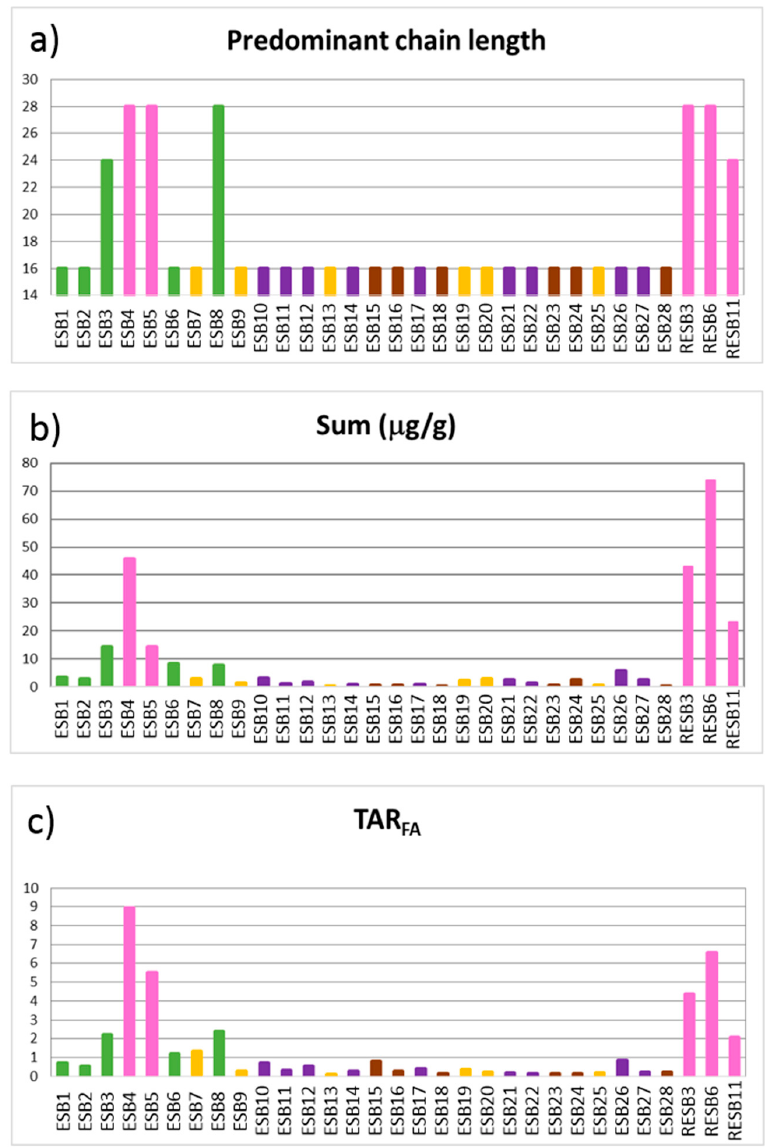
Figure 10. Projection of the proxies from the n -alkanoic acids. ( a ) Predominant chain length (PCL); ( b ) Sum of the concentration of all the n -alkanoic acids; ( c ) Terrigenous/aquatic acid ratio (TARFA). (Green): green clays; (Pink): pink clays; (Purple): illitic samples; (Brown): sandy samples; (Yellow): carbonatic samples.